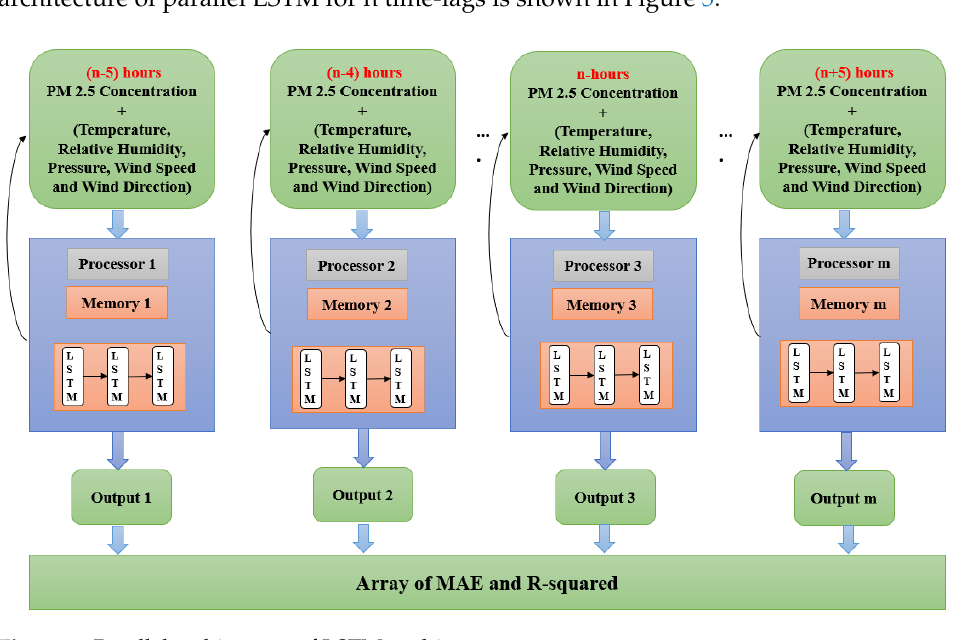
Figure 5. Parallel architecture of LSTM